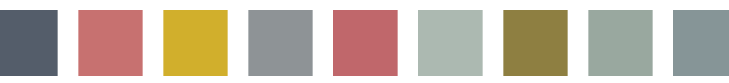
Figure 9: The nine OSA-UCS samples that were not correctly named by the